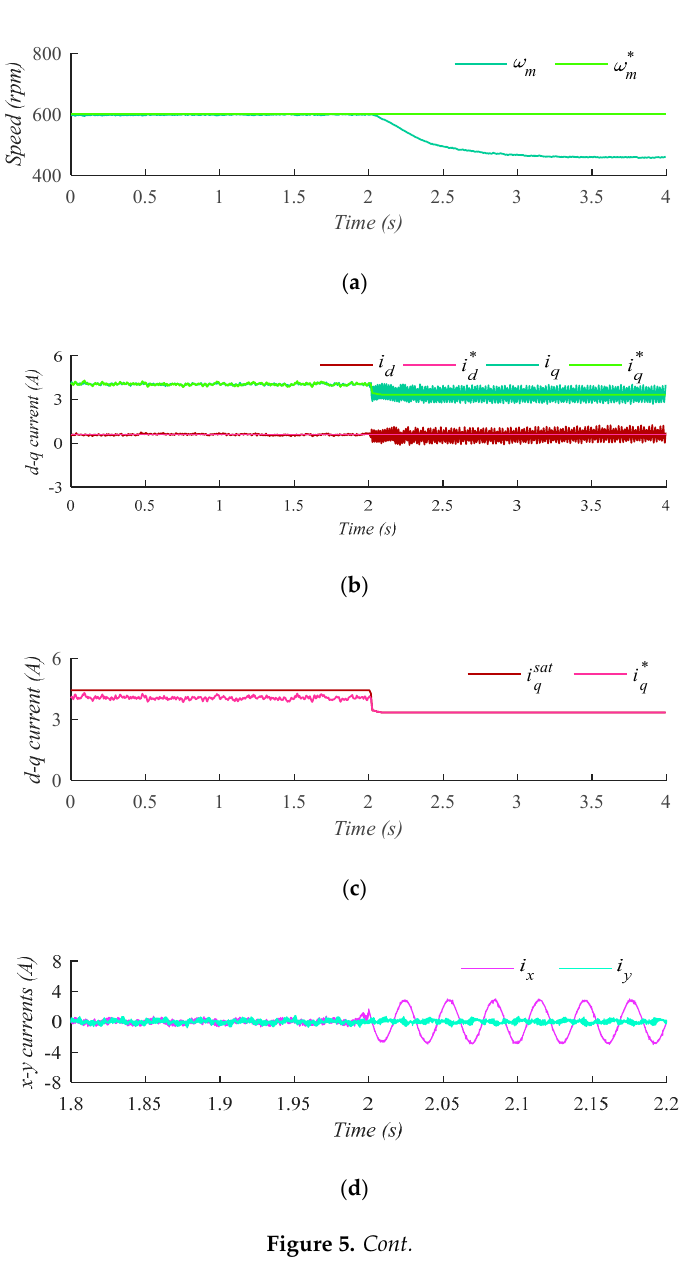
Figure 4. Test 1. Post-fault response when operation point can be maintained. From top to bottom: ( a ) motor speed, ( b ) 𝑑 - 𝑞 currents, ( c ) maximum 𝑞 and 𝑞 reference current, ( d ) 𝑥 - 𝑦 currents, ( e ) set 1 of phase currents and ( f ) set 2 of phase currents.